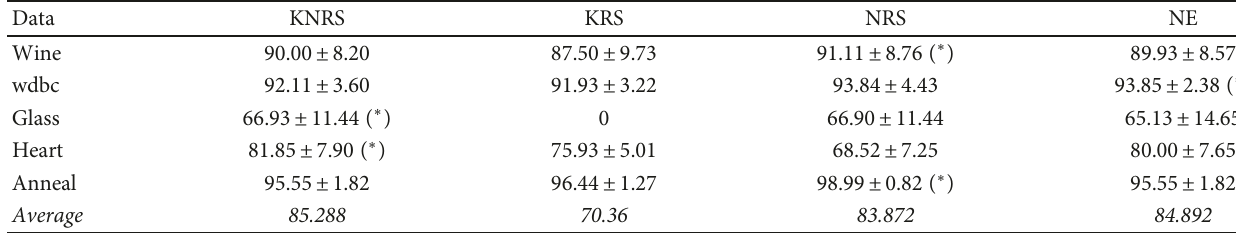
Table 6: Classi fi cation accuracies based on CART (%).